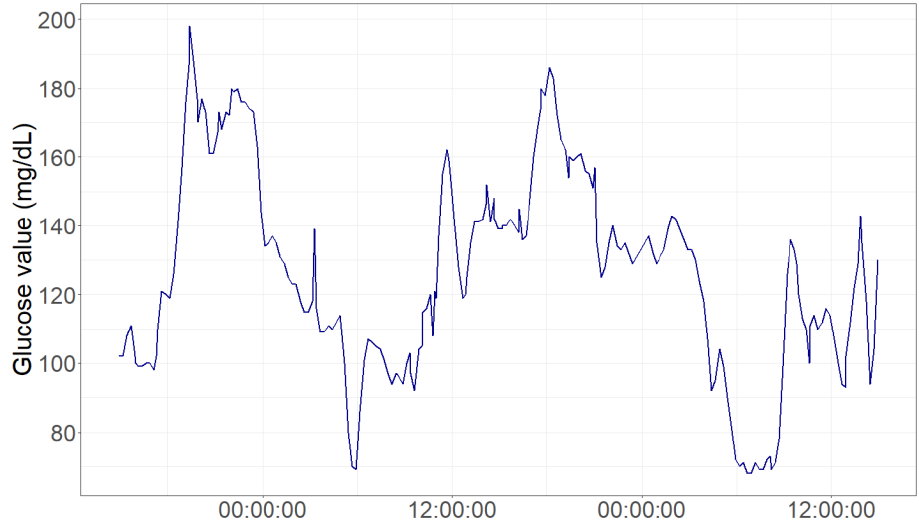
Figure 4. Glycemic fluctuations in a patient 48-h monitoring window.